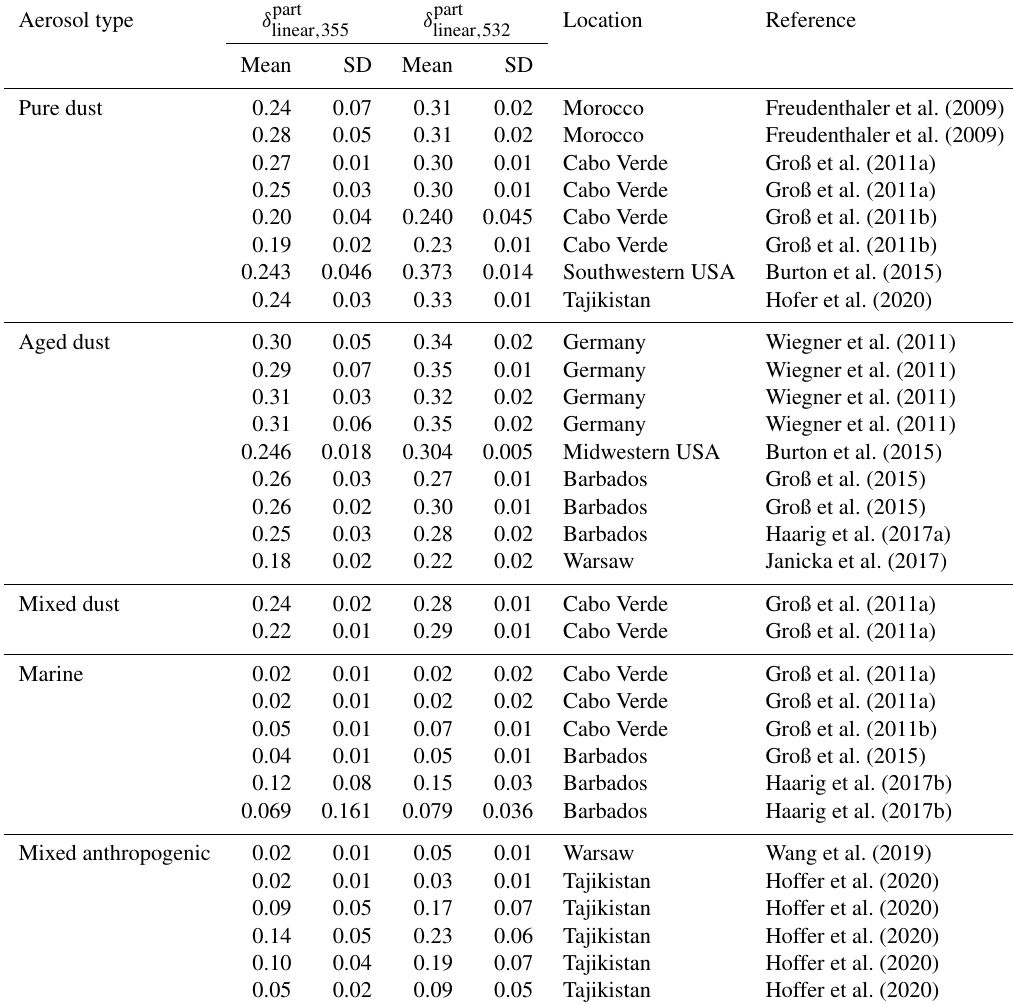
part ) at 355 and 532nm (with the corresponding standard deviation) obtained from the linear is a dimensionless variable. linear